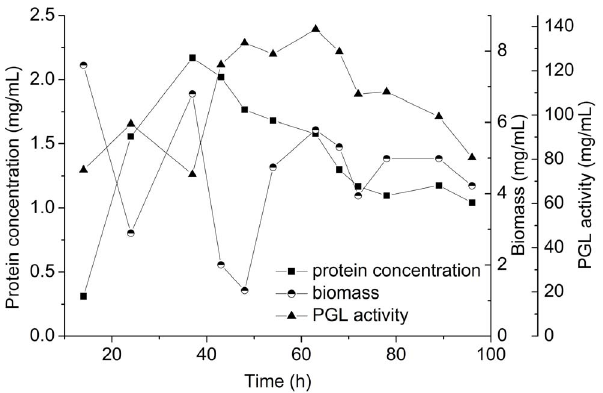
Figure 3. Fermentation results in 7.5 L fermentor using the optimal conditions from shake